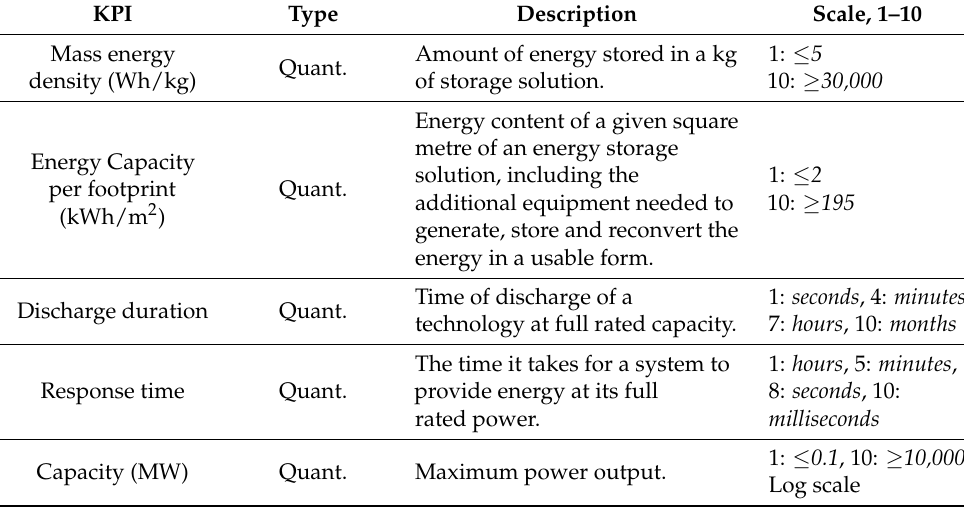
Table 1. Description of the